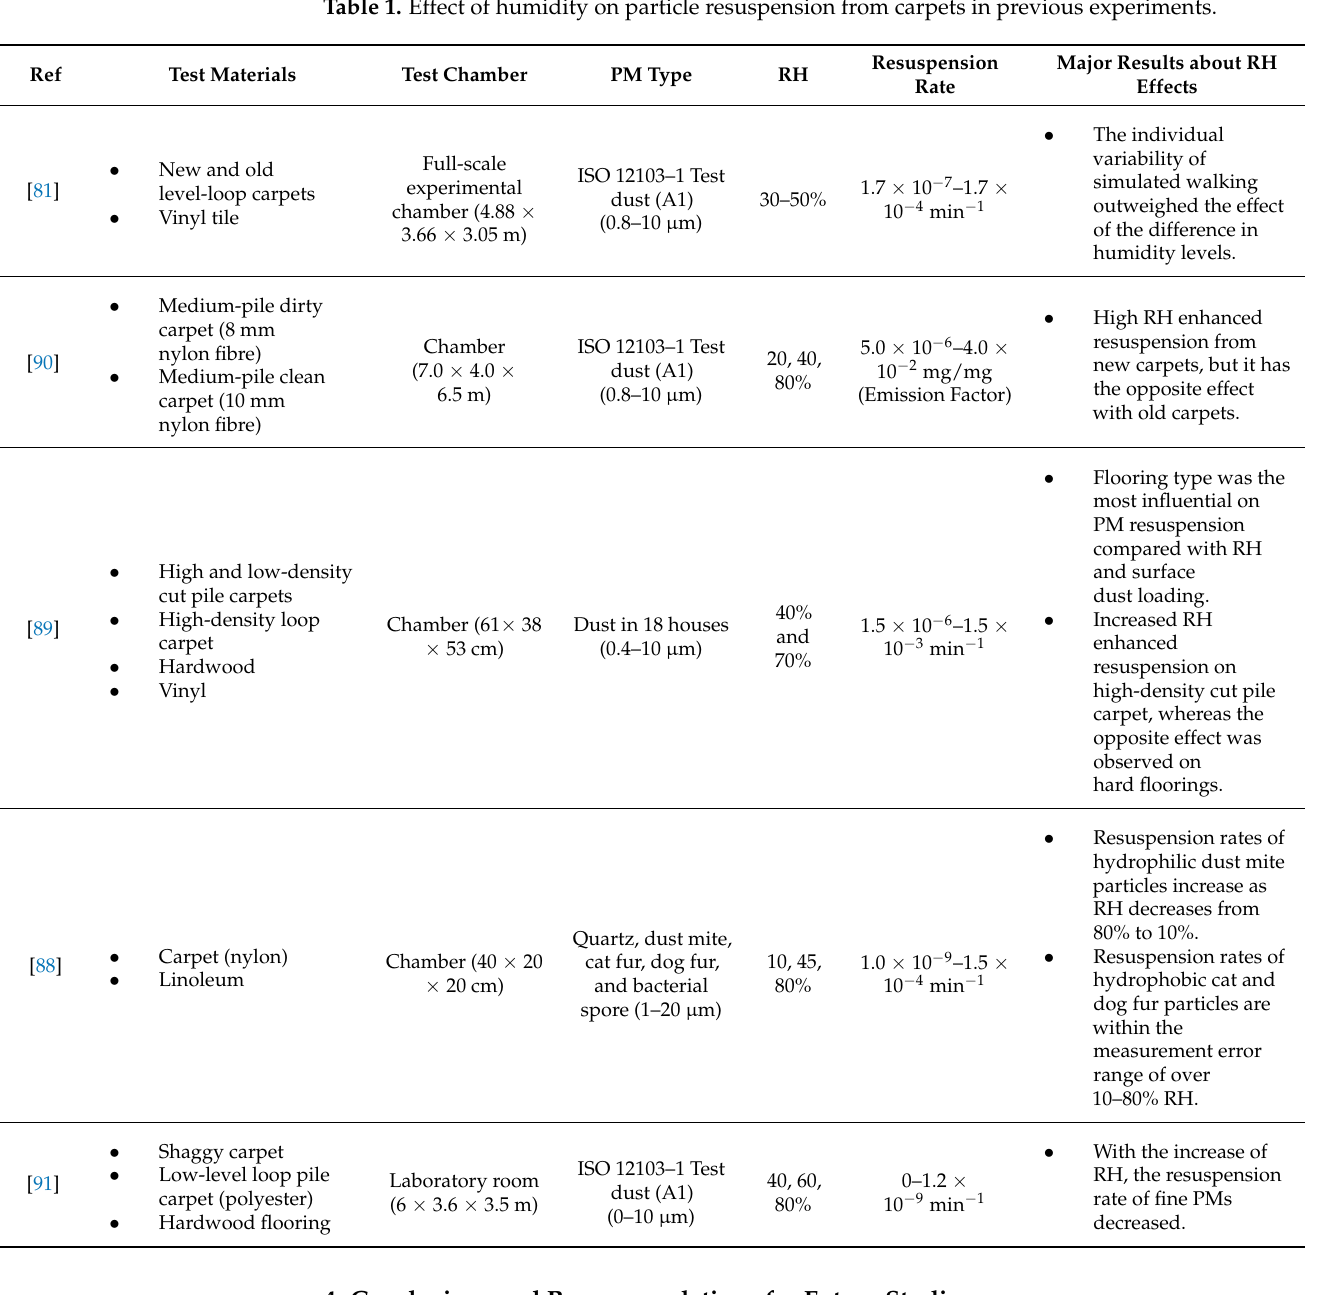
Table 1. Effect of humidity on particle resuspension from carpets in previous